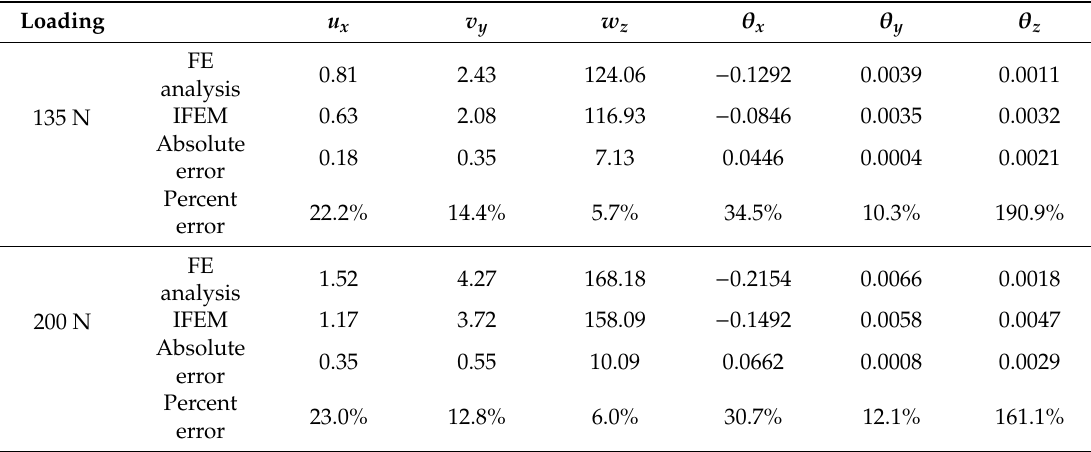
Table 1. The comparison between the FE analysis and the reconstructing using inverse finite element method (iFEM). The displacements are expressed in millimeter and rotations are expressed in radian.